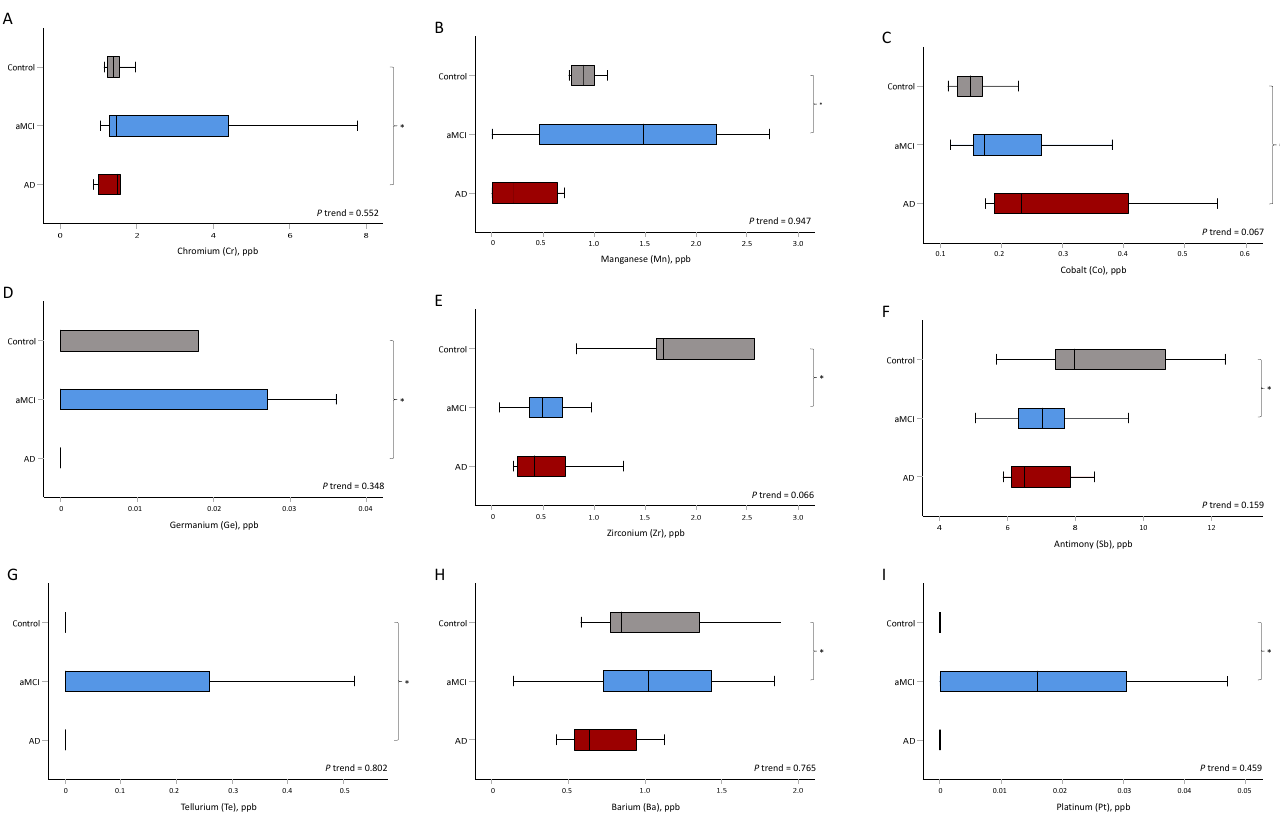
Figure 3. The distribution of trace metals was significantly different between aMCI and control groups and between AD and control groups. Asterisks (*) indicate statistical significance ( p < 0.05). ( A ) Chromium, ( B ) manganese, ( C ) cobalt, ( D ) germanium, ( E ) zirconium, ( F ) antimony, ( G ) tellurium, ( H ) barium, and ( I ) platinum. aMCI, amnestic mild cognitive impairment; AD, Alzheimer’s disease.